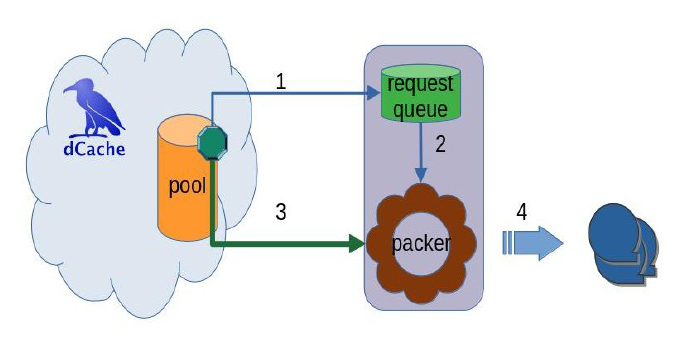
Figure 2: Small File Service operation: (1) request pushed into job